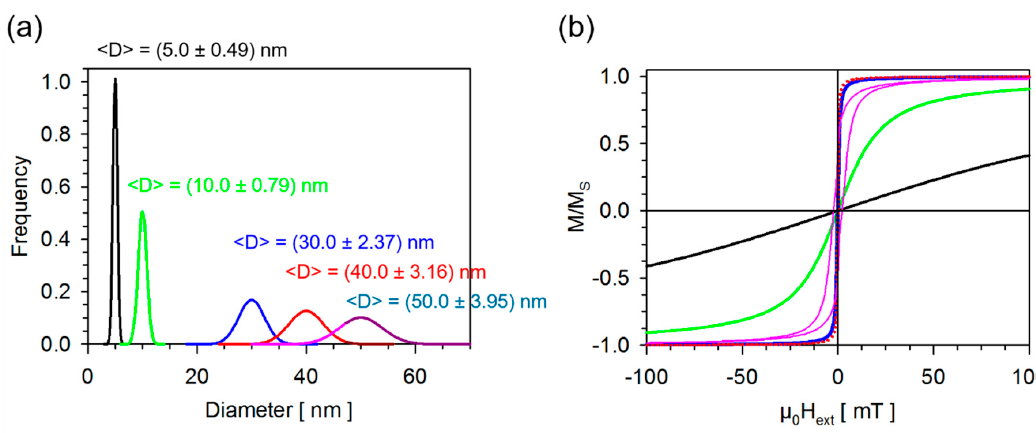
Figure 2. Hysteresis curves of Co 2 MnSi calculated applying Equation (2), assuming the nanoparticle size distributions provided in ( a ) to monitor the transition from purely superparamagnetic behavior towards partly ferromagnetic behavior. Associated curves in ( a ) and ( b ) have the same color code. ( a ) Underlying nanoparticle size distributions of Co 2 MnSi color-coded, characterized by their mean size and assumed standard deviation; ( b ) The resulting magnetization reversal of each nanoparticle distribution is calculated using Equation (2) considering a mixture of partly superparamagnetic particles and partly ferromagnetic ones. The transition between pure superparamagnetic towards ferromagnetic behavior will not occur until the superparamagnetic limit of Co 2 MnSi. Thus, it is reflected in the visible coercivity. Nanoparticles with diameters of 30 nm and beyond show a very large susceptibility.